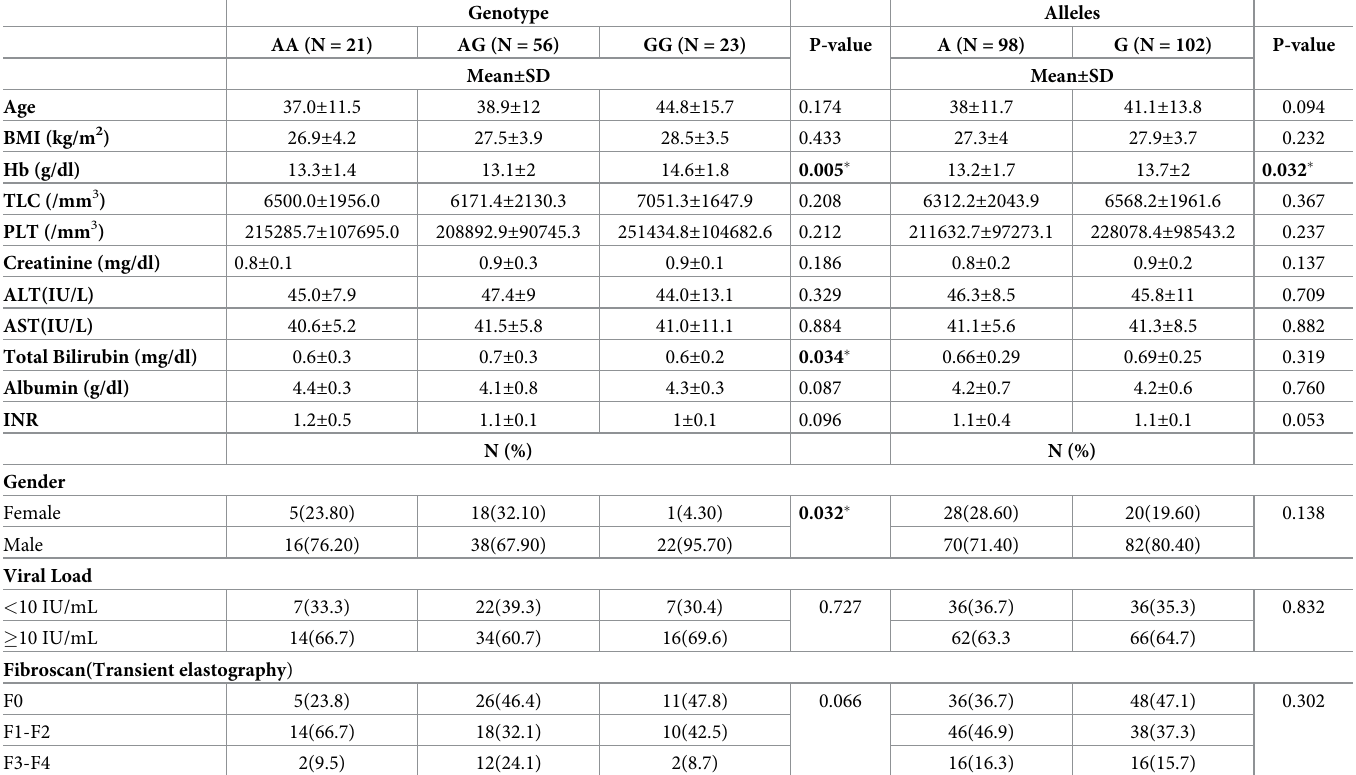
Table 4. The miR-146a A/G polymorphism (rs57095329) to the characteristics of cases with chronic hepatitis B viral infection. Genotype